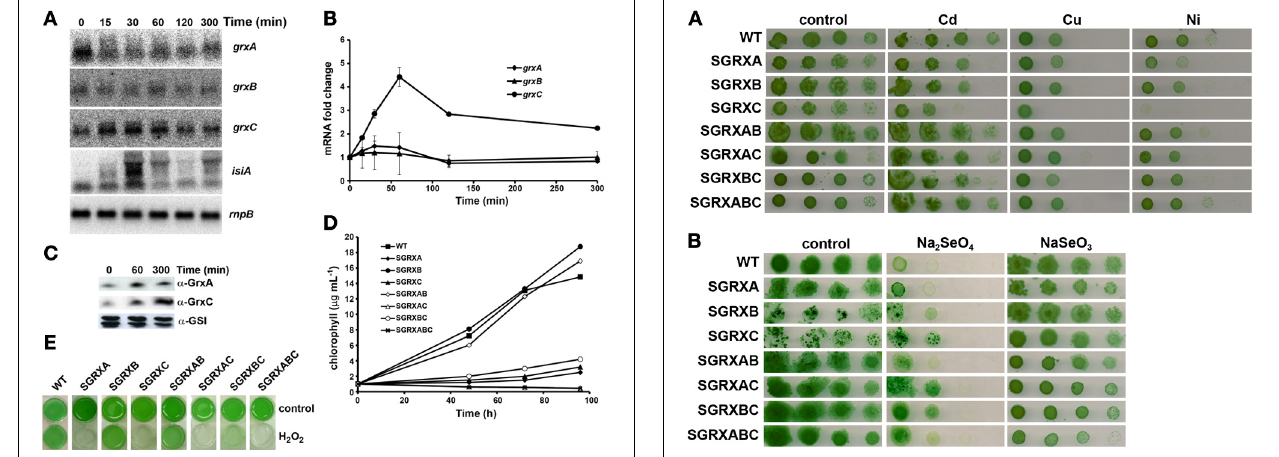
FIGURE 5 | Effect of H 2 O 2 addition on glutaredoxin gene expression and growth. (A) Northern blot analysis of grxA , grxB , grxC, and isiA expression in response to H 2 O 2 addition. Total RNA was isolated from WT cells grown in BG11C at the indicated times after a 1mM H 2 O 2 addition. The filter was hybridized with grxA , grxB , grxC, and isiA probes and subsequently stripped and re-hybridized with an rnpB probe as a control. (B) Quantification of relative mRNA levels of grxA , grxB, and grxC in response to H 2 O 2 addition. Radioactive signals were quantified and normalized to the rnpB signal. Plots of relative mRNA levels vs. time were drawn; data represent average of 3 independent experiments and error bars represent SE. grxA ( (cid:4) ), grxB ( (cid:2) ), and grxC ( • ). (C) Western blot analysis of GrxA and GrxC levels in response to hydrogen peroxide. WT cells grown in BG11C and samples were collected at the indicated times after 1mM H 2 O 2 addition. Fifteen microgram of total protein from soluble extracts were separated by 15% SDS-PAGE and subjected to western blot to detect GrxA, GrxC, and GSI. (D) Growth of glutaredoxin mutants strains after H 2 O 2 addition. WT ( (cid:3) ), SGRXA ( (cid:4) ), SGRXB ( • ), SGRXC( (cid:2) ), SGRXAB ( ♦ ), SGRXAC ( (cid:3) ), SGRXBC ( (cid:4) ), and SGRXABC (x) were grown until the exponential phase, diluted to 1 μ g chlorophyll mL − 1 and 1mM H 2 O 2 was added. Growth was monitored by measuring chlorophyll content. (E)